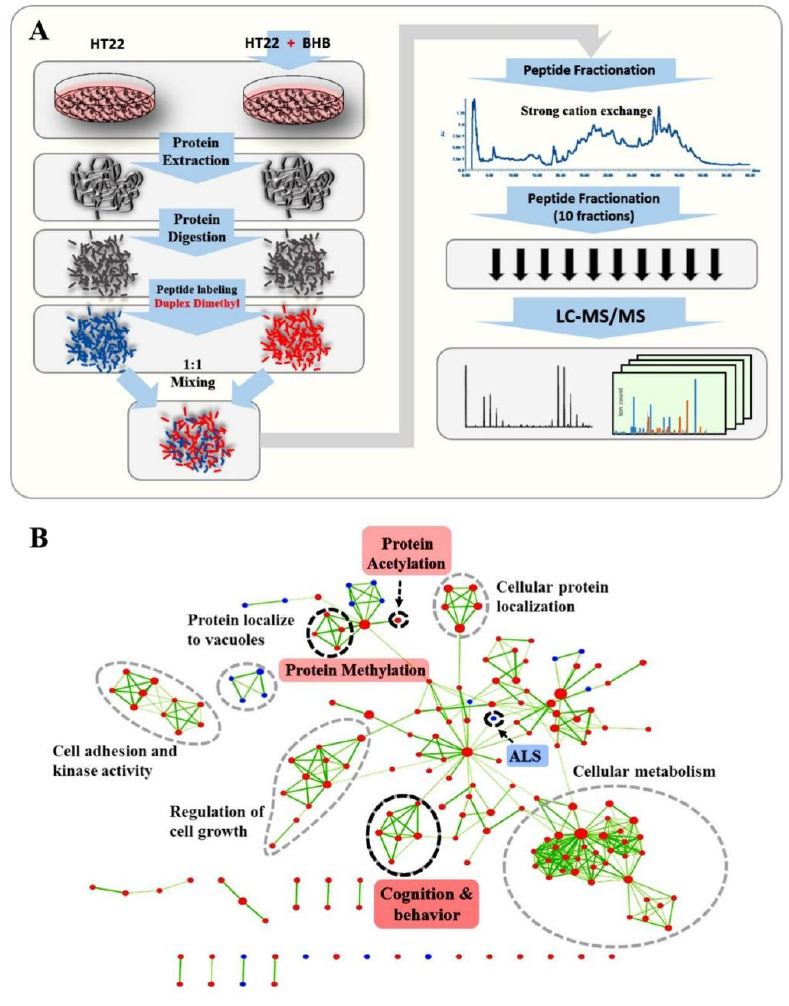
Figure 1. Proteomics Workflow and GSEA Analysis . ( A ) HT22 cells were treated with 0.2 mM of β ‑hydroxybutyrate (3OHB) and a mock solution, respectively. Cells were then processed for MS‑based dimethyl‑labeling quantitative proteomics analysis. ( B ) GSEA was applied to extract an enriched gene ontology map from the proteomics data. As indicated by the pink tag, pathways related to protein acetylation, neurodegenerative disease, ALS and cognition were especially highlighted, which was in good agreement with previous studies. At the same time, biological processes related to protein methylation also showed sensitive responses to 3OHB administration in normal